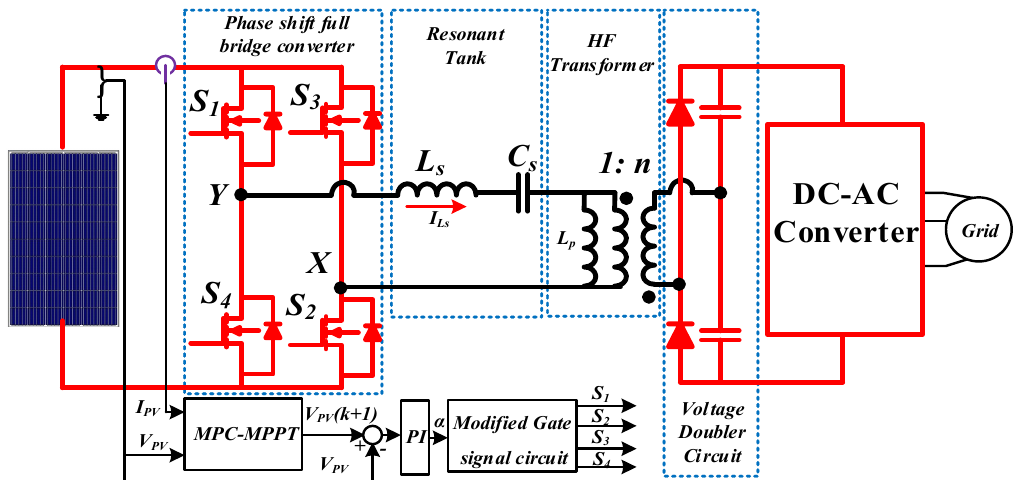
Figure 2. Proposed two-stage micro-inverter with LLC resonant converter.